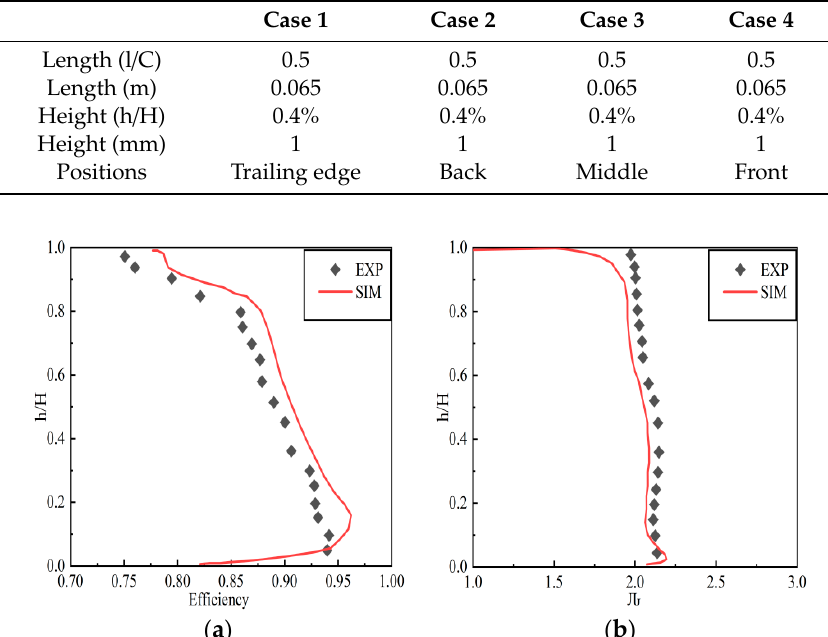
Figure 2. Partial clearance schemes for ( a ): Case 1, ( b ): Case 2, ( c ): Case 3, and ( d ) Case 4.